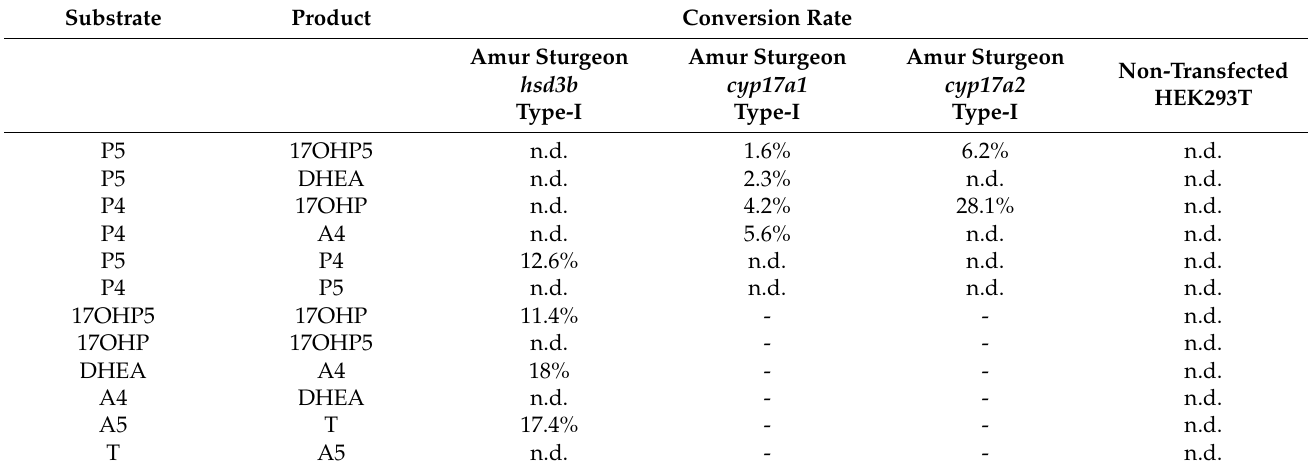
Table 2. Substrate specificity of Amur sturgeon hsd3b, cyp17a1 and cyp17a2.